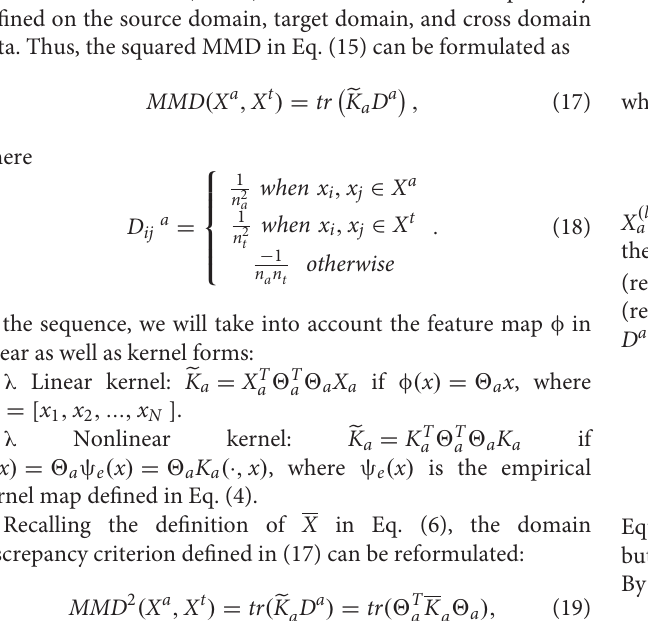
FIGURE 2 | Domain adaptation emotion recognition on within-dataset (SI: Session I, SII: Session II, SIII: Session III). where e K a , e K t , and e K at (or e K ta ) are the Gram matrices